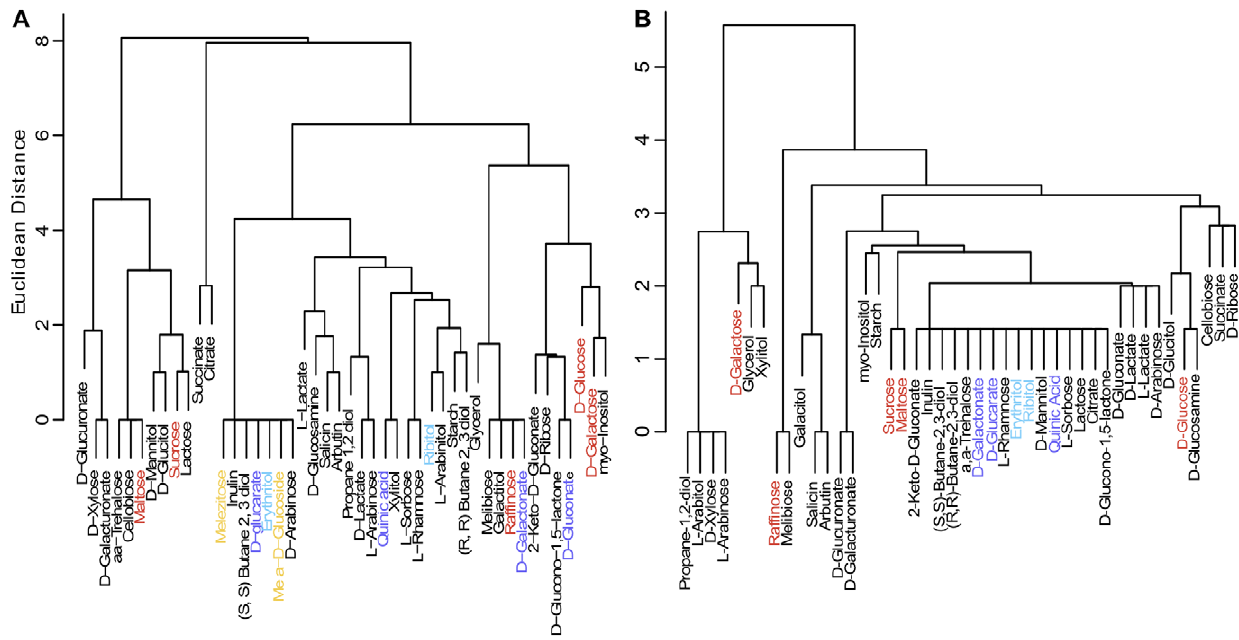
Figure 4. The clustering of carbon sources by (A) their metabolic pathways and (B) enzymes they directly interact with are each different from the clustering of carbon sources by their utilization across strains. The coloring of leaves in A and B corresponds to carbon sources from significant clusters in Figure 3. The lack of correspondence between these analyses suggests that patterns of gain and loss of carbon utilization traits are not driven by the metabolic pathways in which they are found. Clustering was performed by Ward’s method.